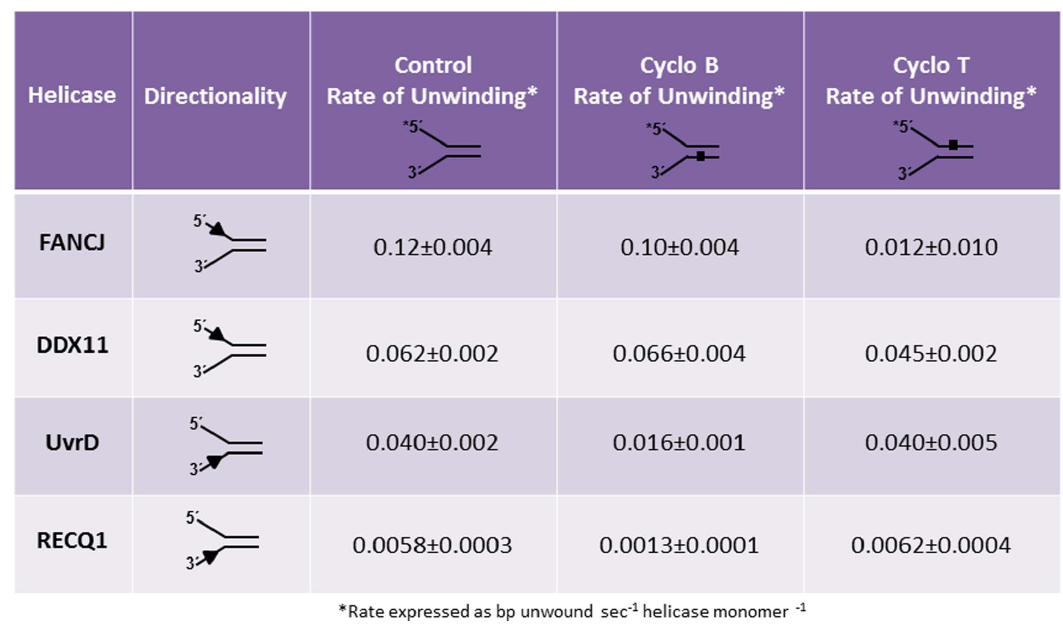
Figure 9. Protein trap kinetic rates for FANCJ, DDX11, RECQ1, and EcUvrD. Rates of unwinding were calculated for each helicase on undamaged DNA substrates and DNA substrates containing a cyclo dA damage in the translocating or non-translocating strand. Rates were determined based on experimental data from Figure 8.